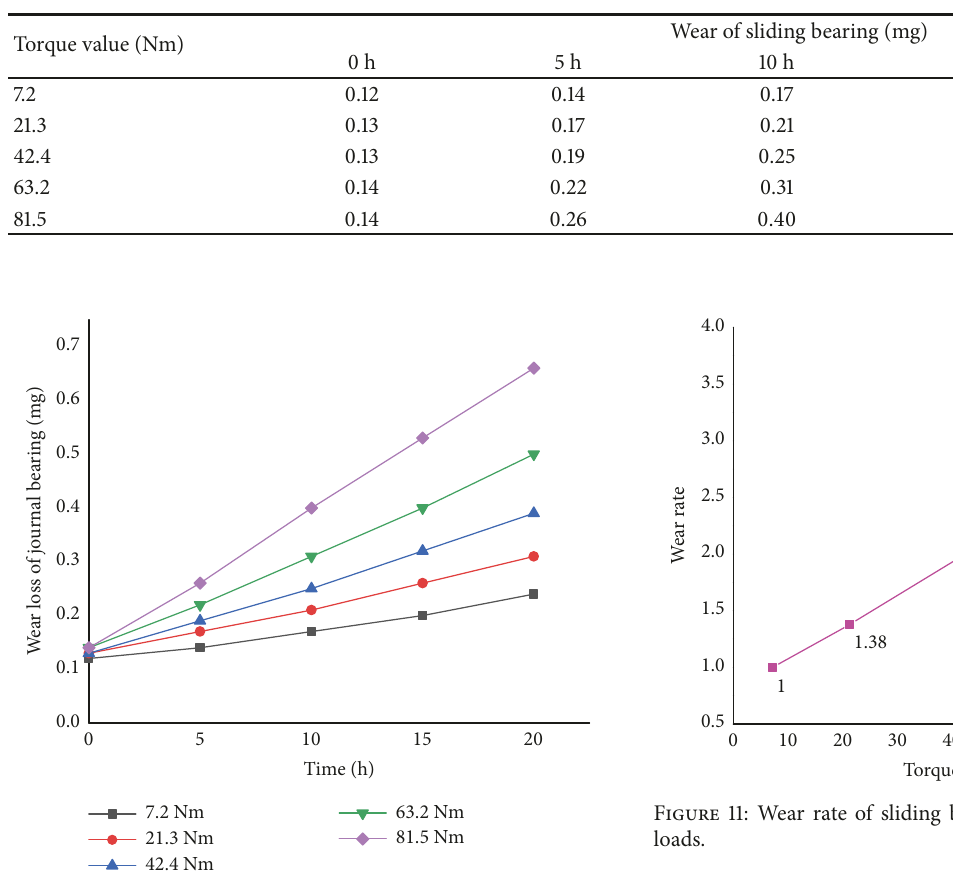
Figure 10: Time-wear curve of sliding bearing II under different torque excitations.